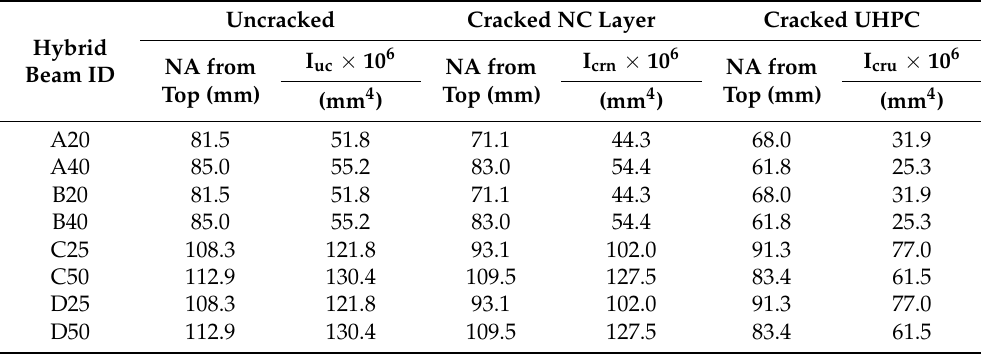
Table 9. Calculated NA depth and MI of hybrid